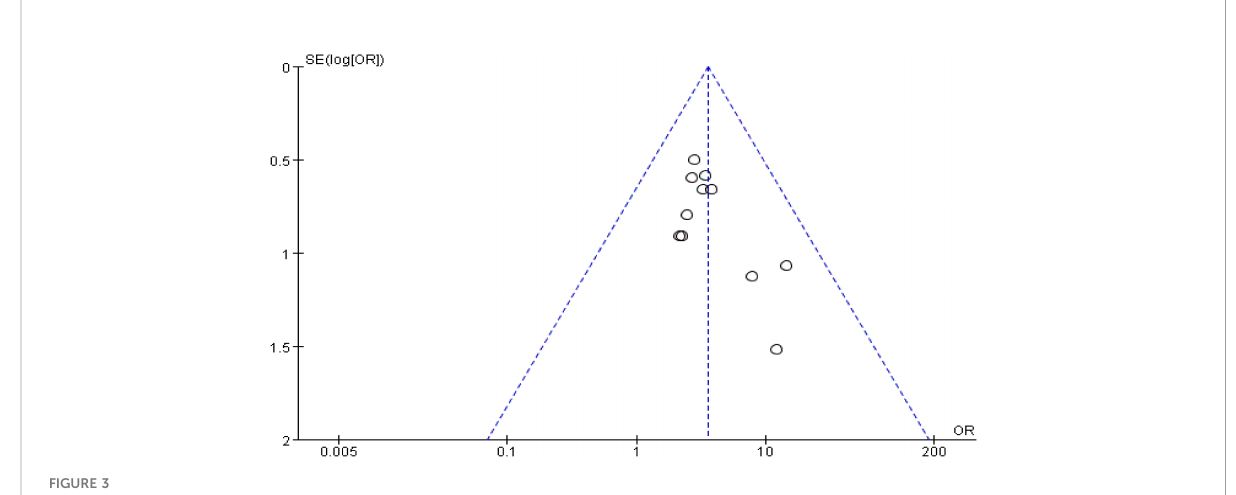
FIGURE 3 Funnel plot of total effective rate after